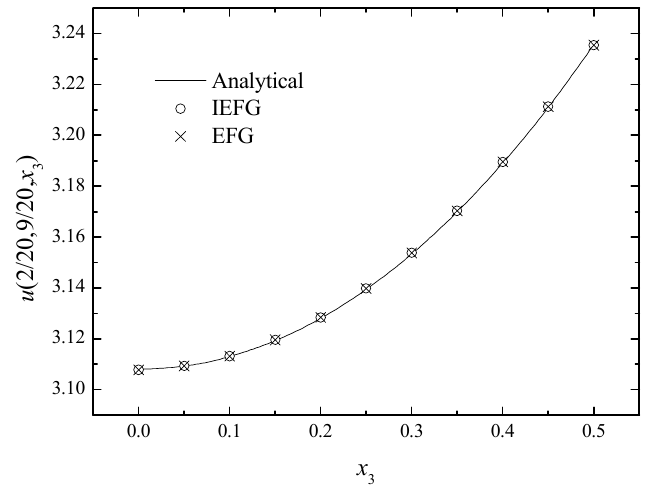
Figure 6. The comparison of numerical and exact solutions along x 3 -axis. Table 2. The analytical and numerical solutions of u ( x 1 , 2/20, 3/20).